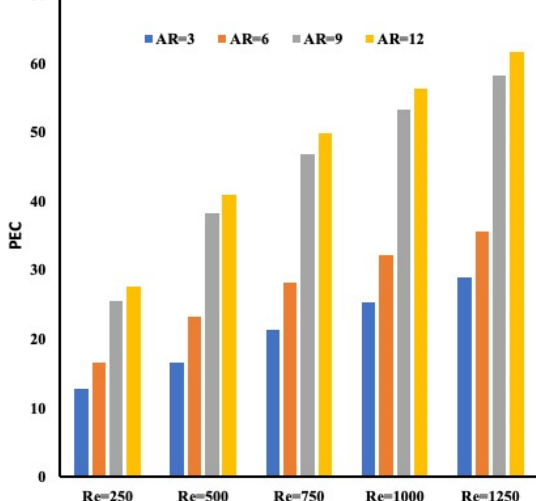
Figure 11. Performance coefficient for all cases.